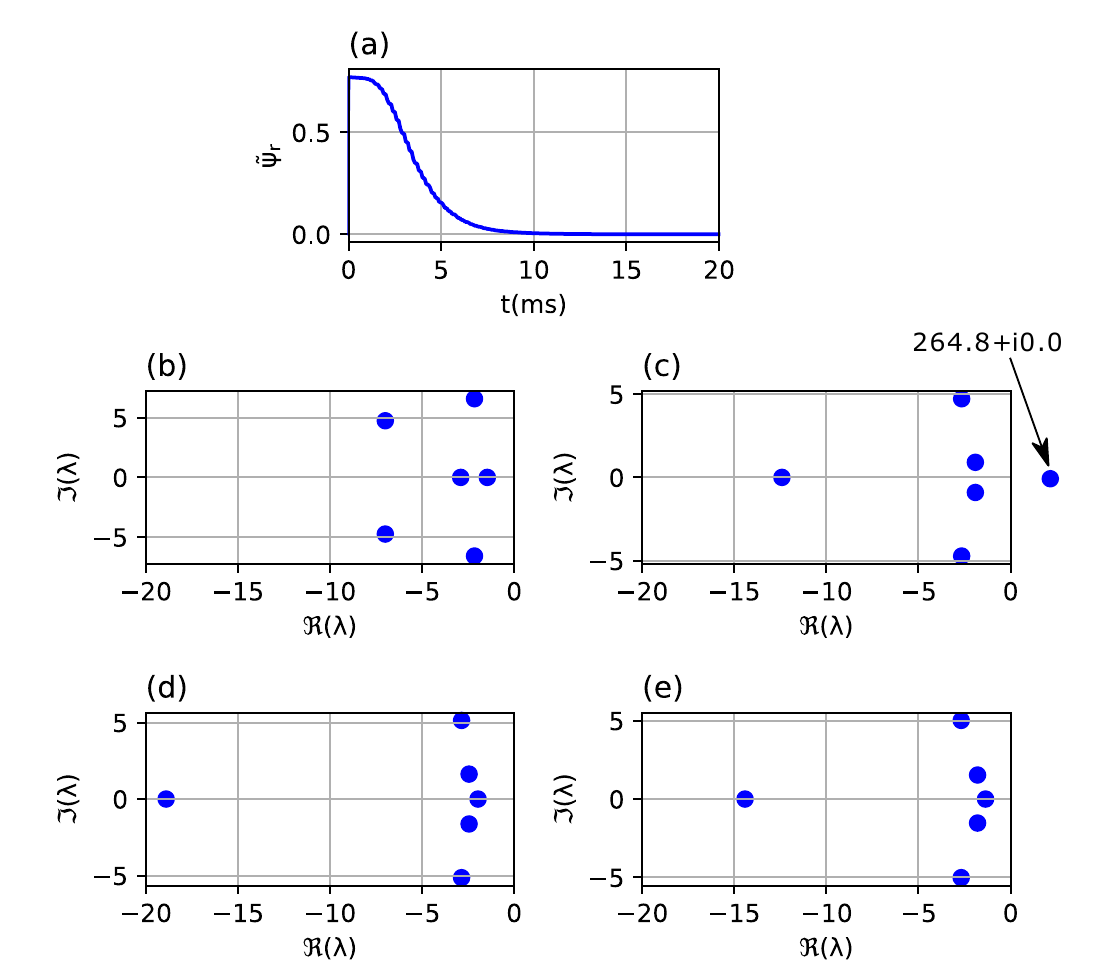
Figure 5. Signal length influence on observer dynamics identification: ( a ) impulse response of the system, ( b ) poles of the linearized system, ( c ) poles of an identified system based on signal length of 3.75 ms (25 samples), ( d ) poles of an identified system based on signal length of 15 ms (100 samples), ( e ) poles of an identified system based on signal length of 75 ms (500